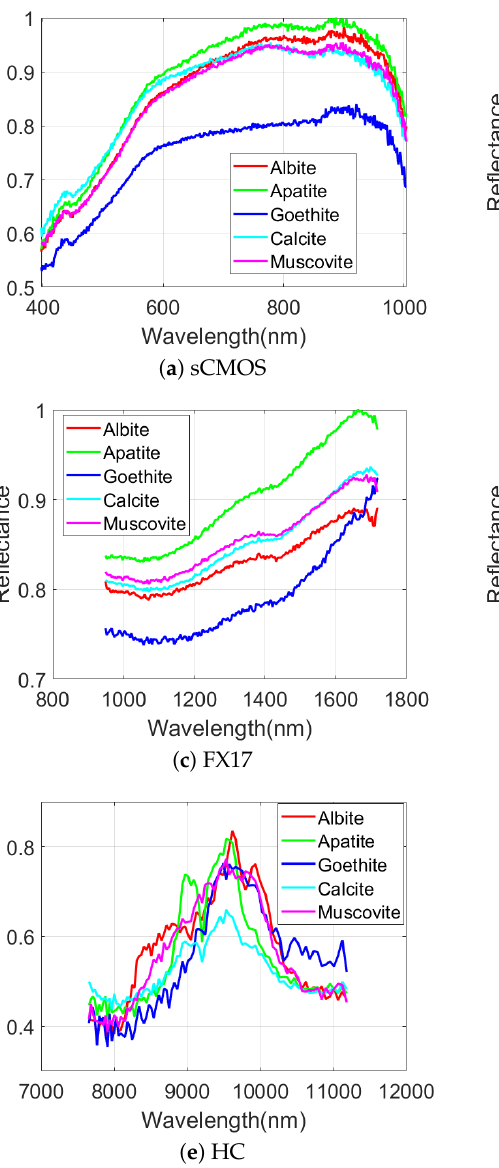
Figure 9. The spectral behaviors of different mineral classes of the RZ2 dataset for different hyperspectral sensors. The results are based on spectral means over the minerals’ labels from the training